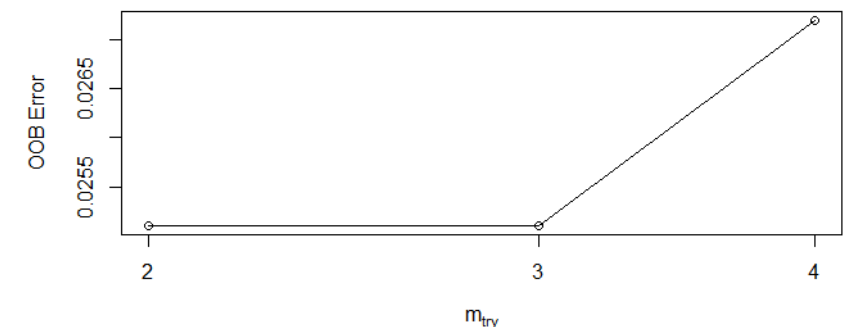
Figure 19. Selecting the split